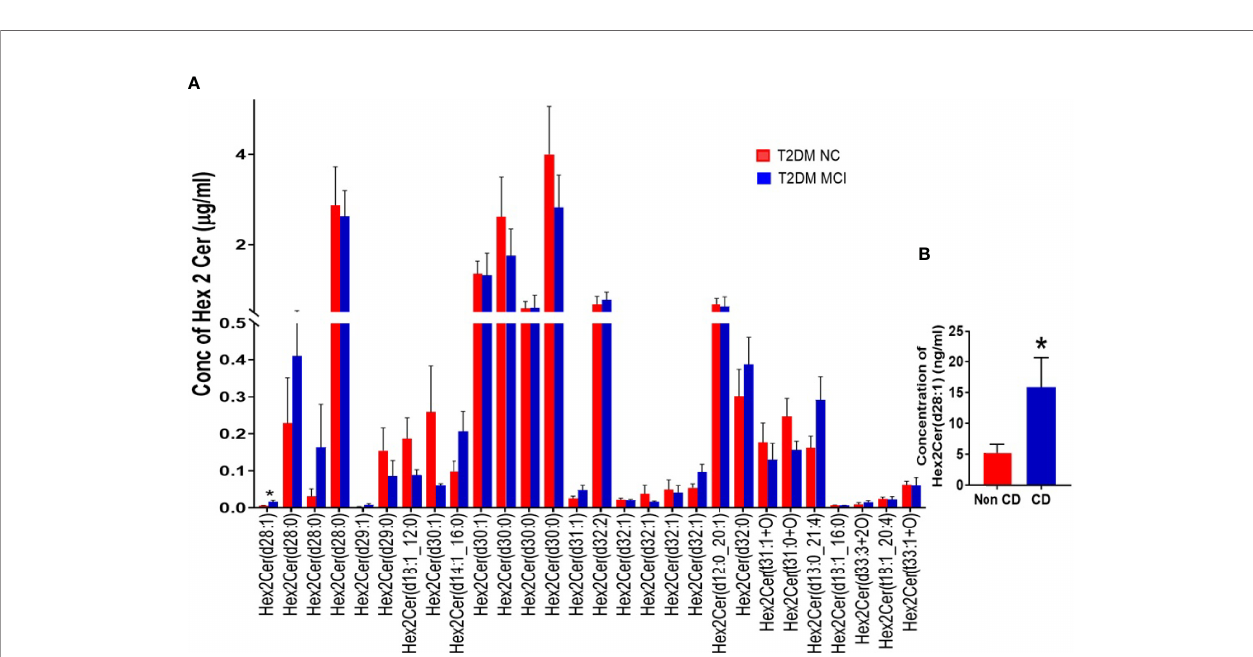
FIGURE 6 | A detailed evaluation of the concentrations of individual species of dihexosylceramides (Hex 2 Cer) in patients with MCI compared to the NC group of T2DM patients (A) . Among 28 species of Hex 2 Cer species (A) , Hex2Cer (d28:1) levels were signi fi cantly higher in the MCI group compared to NC groups [*p < 0.05, (A, B) ]. Although variations were observed among several other Hex2Cer species, no signi fi cant differences were found between the two groups.